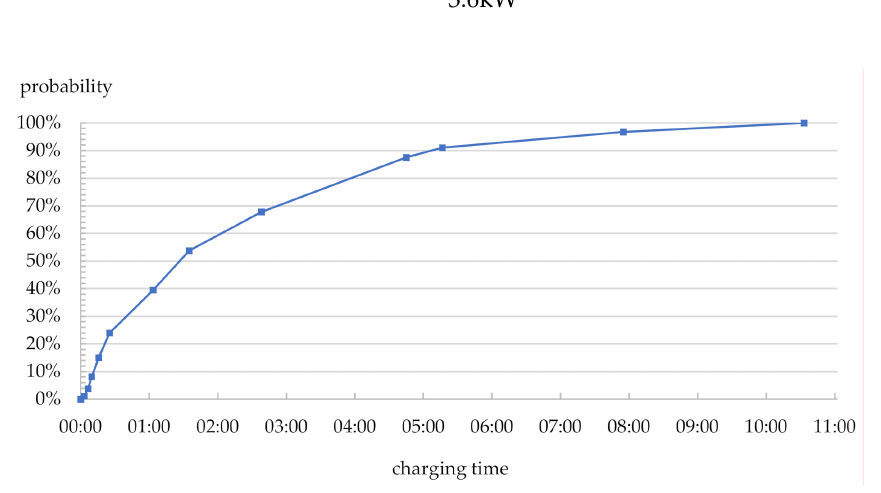
Figure 9. Cumulative distribution function of the resident’s EV full